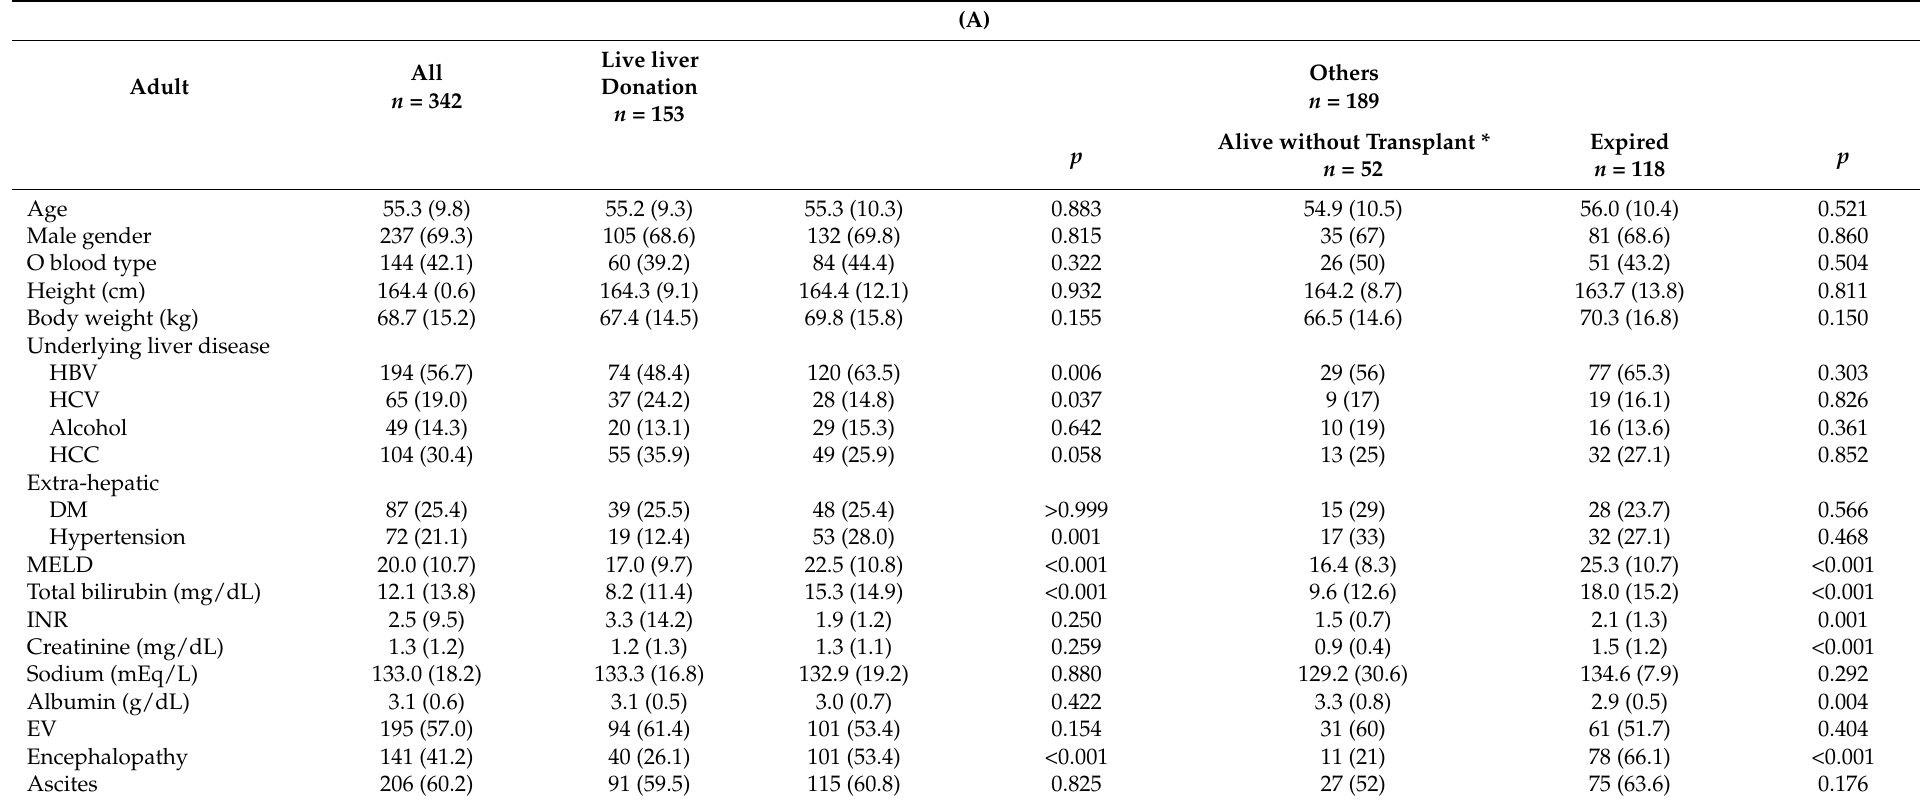
Table 1. Characteristics of intention-to-receive live donor transplant candidates. Live donor transplants vs. others in adult ( A ) and pediatric ( B )